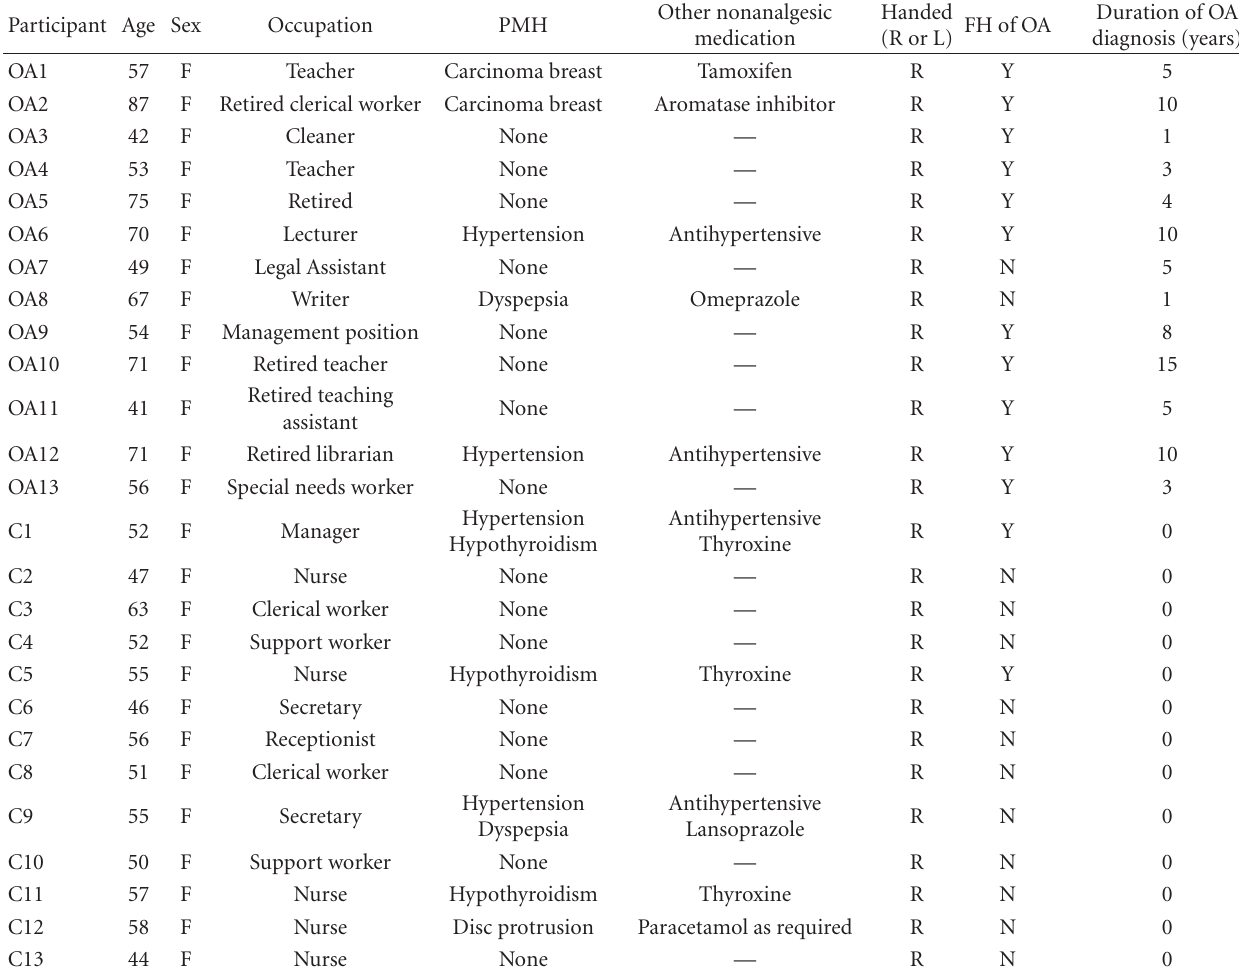
Table 3: Participant cohort demographics. The age, gender, family history of OA, past medical history and concomitant medication in the hand OA (OA1–OA13), and healthy controls (C1–C13) are